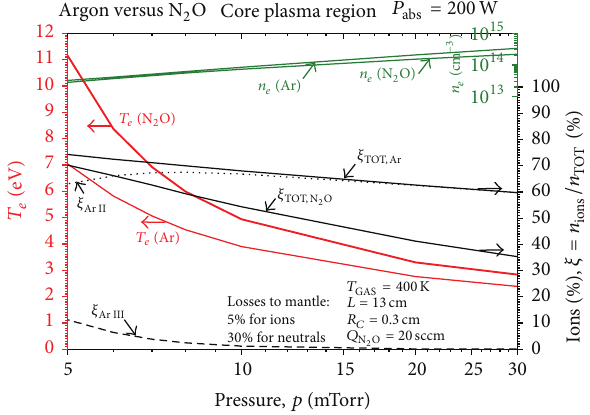
Figure 7: Comparison of 𝑇 𝑒 , 𝑛 𝑒 , and ionized species percentage for N 2 O and for Ar in the “core” region of a HPT of 200W absorbed power and 20sccm flow rate. Pressure varies from 5mTorr to 30 mTorr.